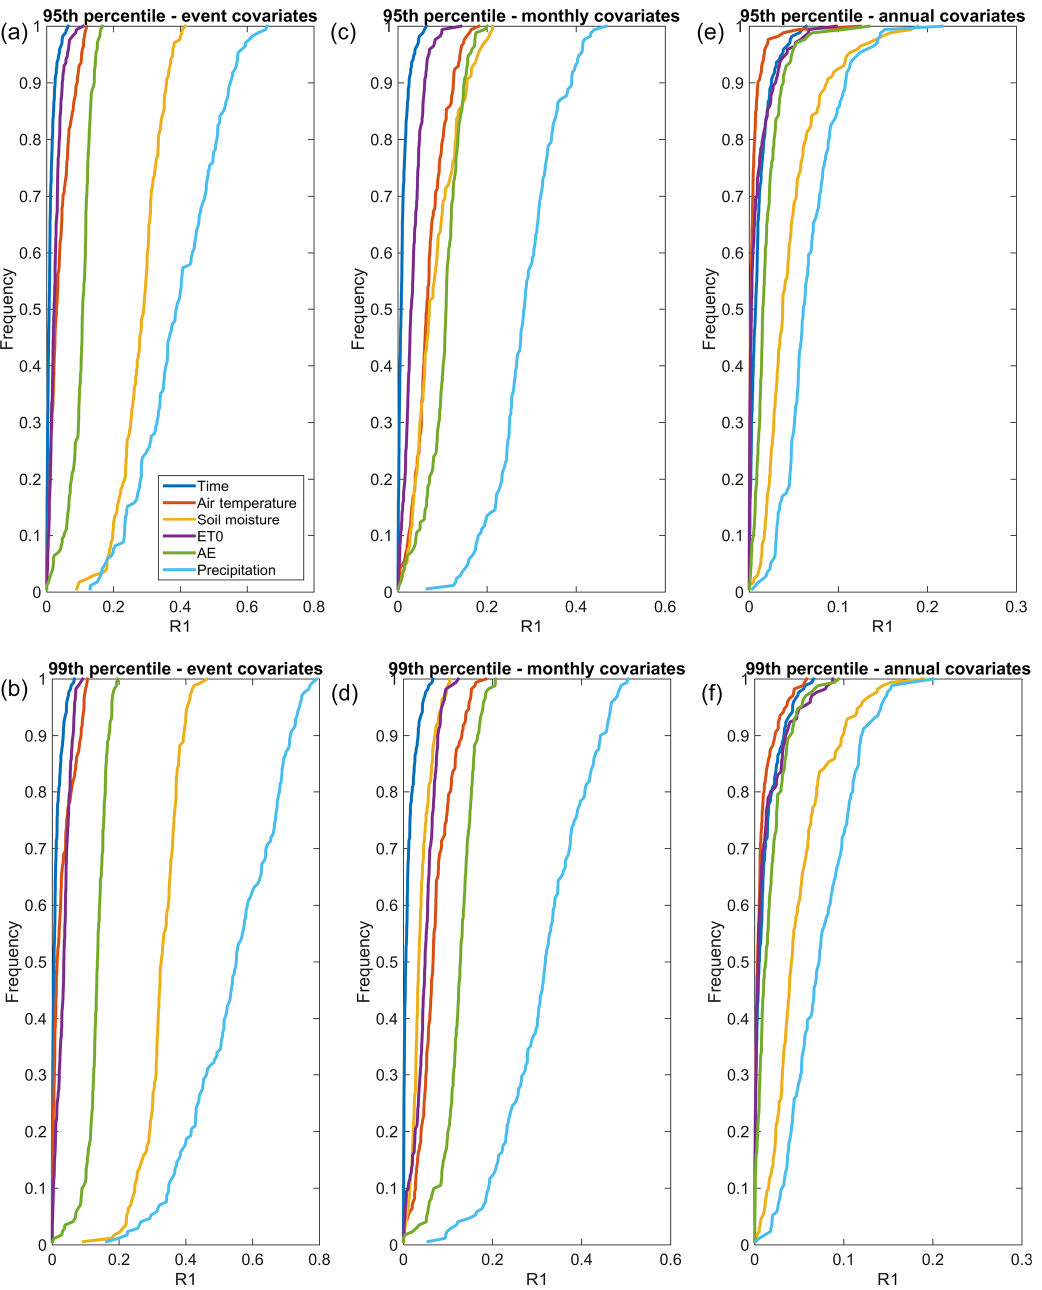
Figure 7. Distribution of the R 1 coefficients for different covariates for the 95th or 99th percentiles of daily runoff, averaged at ( a, b ) the event scale (3d), (c, d) the monthly scale, and (e, f) the annual timescale.